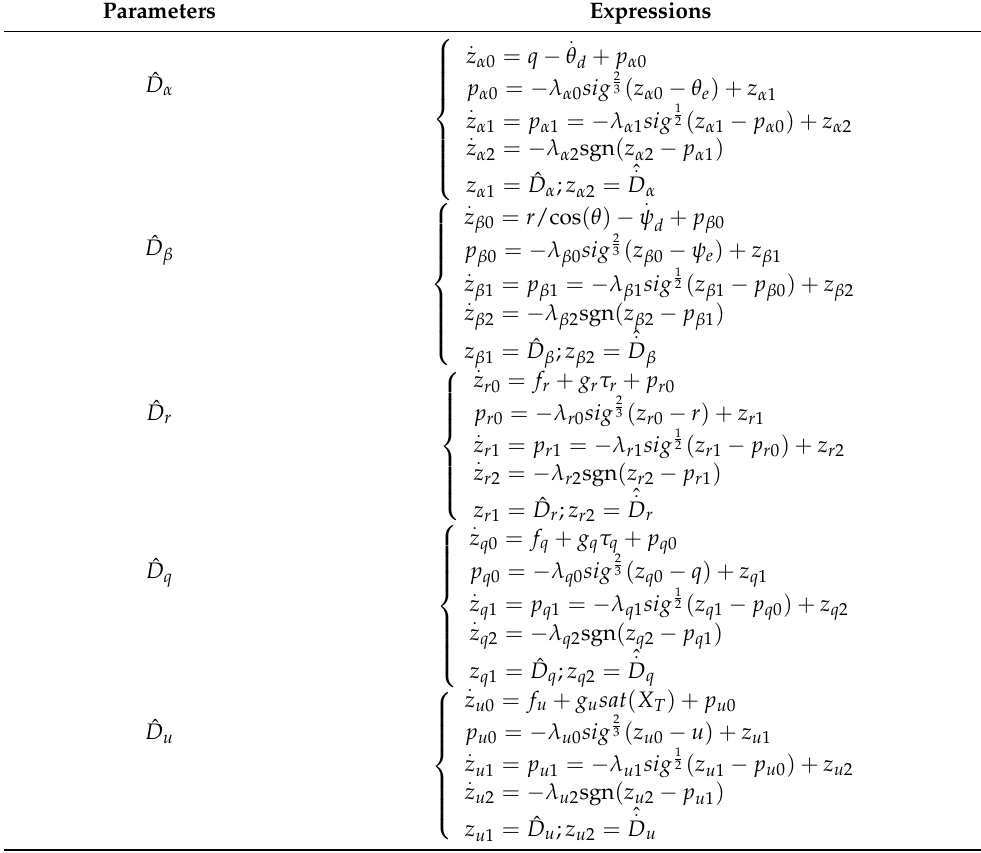
Table A1. The expressions of FTEDOs. Parameters